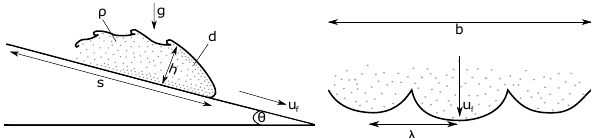
Fig. 2. Schematic diagrams of a particulate gravity current of height h , width b , density ρ travelling a distance s down an inclined plane with a front velocity u f . The particulate material has a diameter d and a lobe and cleft pattern with wavelength λ forms at the moving